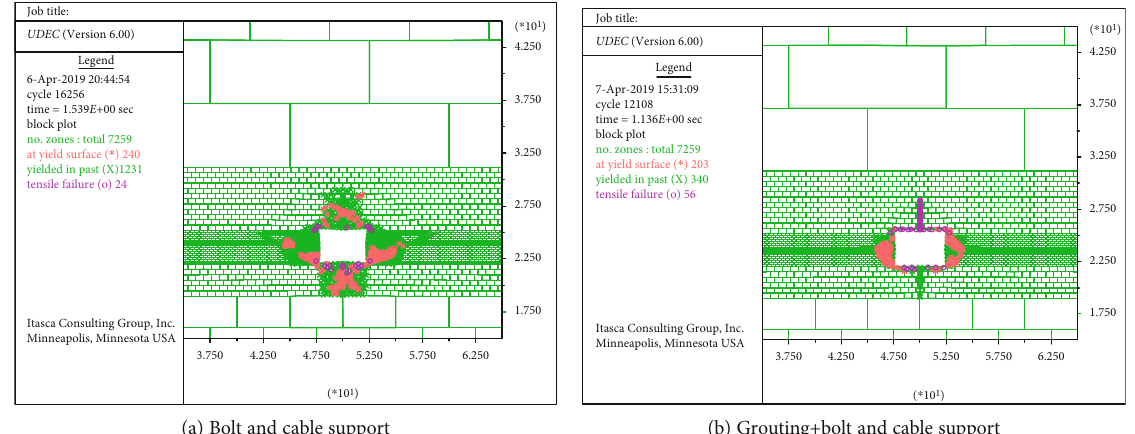
Figure 6: Distribution characteristics of plastic zone in surrounding rock of roadway.